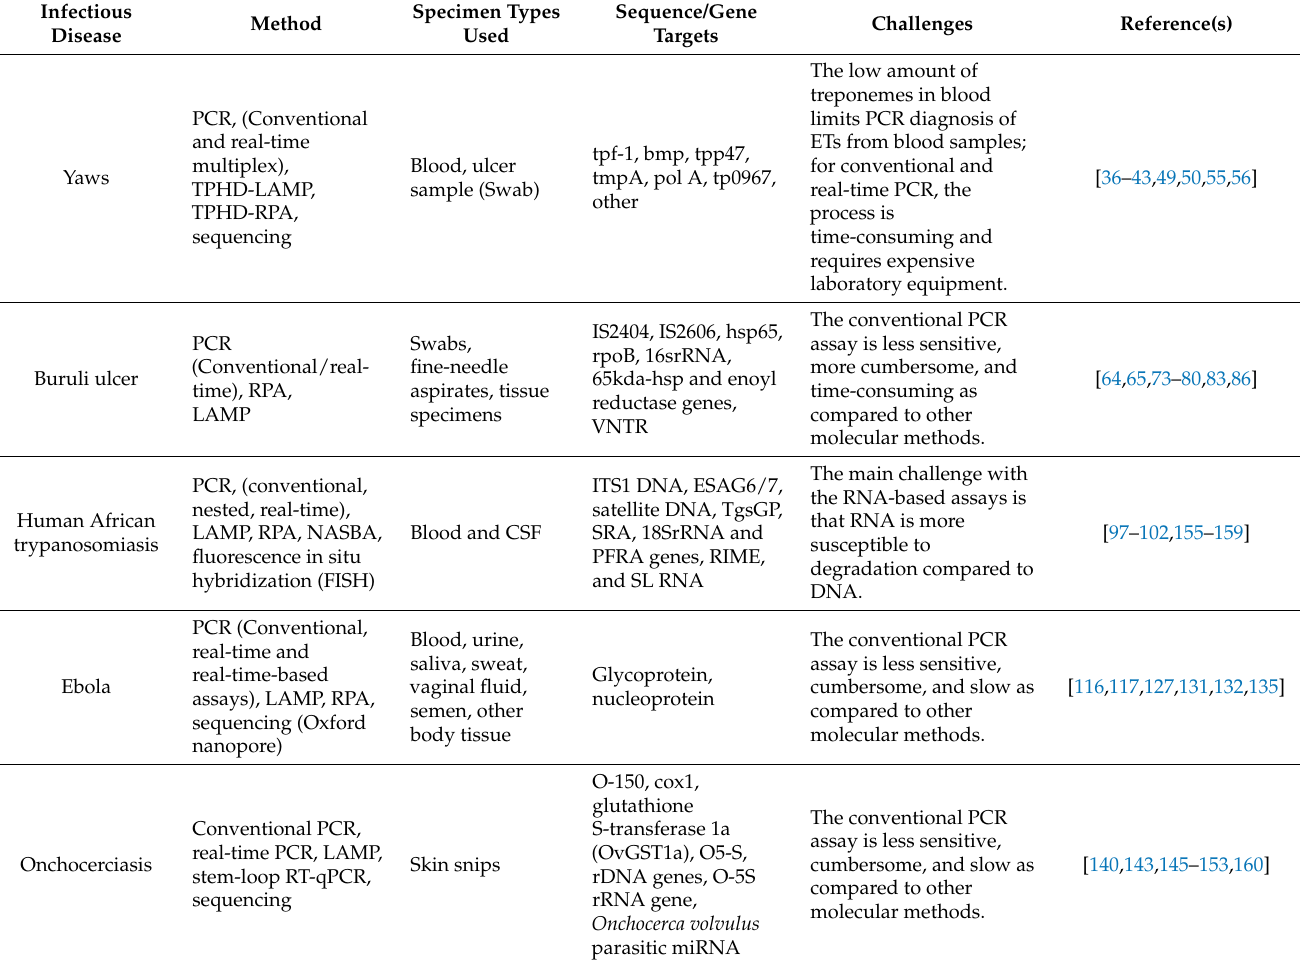
Table 2. Nucleic-acid-based methods of infectious disease